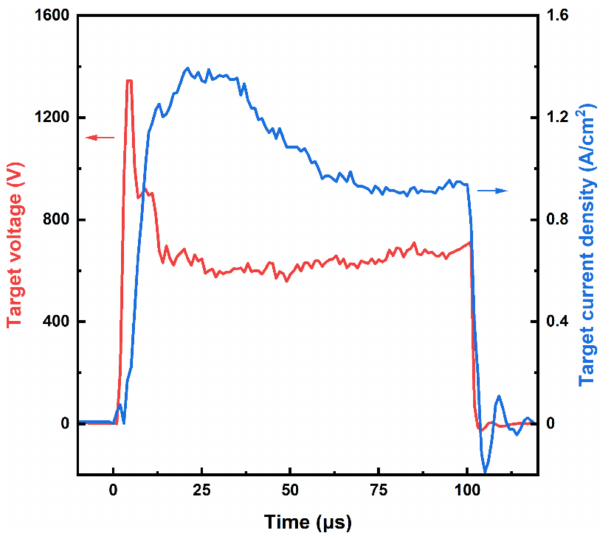
Figure 2. The target voltage and target current density for 100 µ s HiPIMS pulse used for Cr 2 N/TiN multilayer coatings depositions. Table 1. Experiment parameters of the Cr 2 N/TiN multilayer films deposited by HiPIMS and AIP hybrid technology. Parameter Target materials (99.9